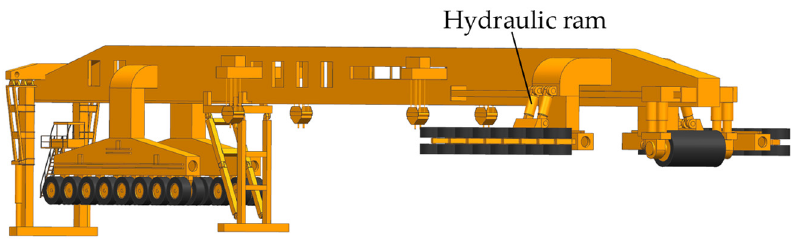
Figure 27. Beam delivery state.